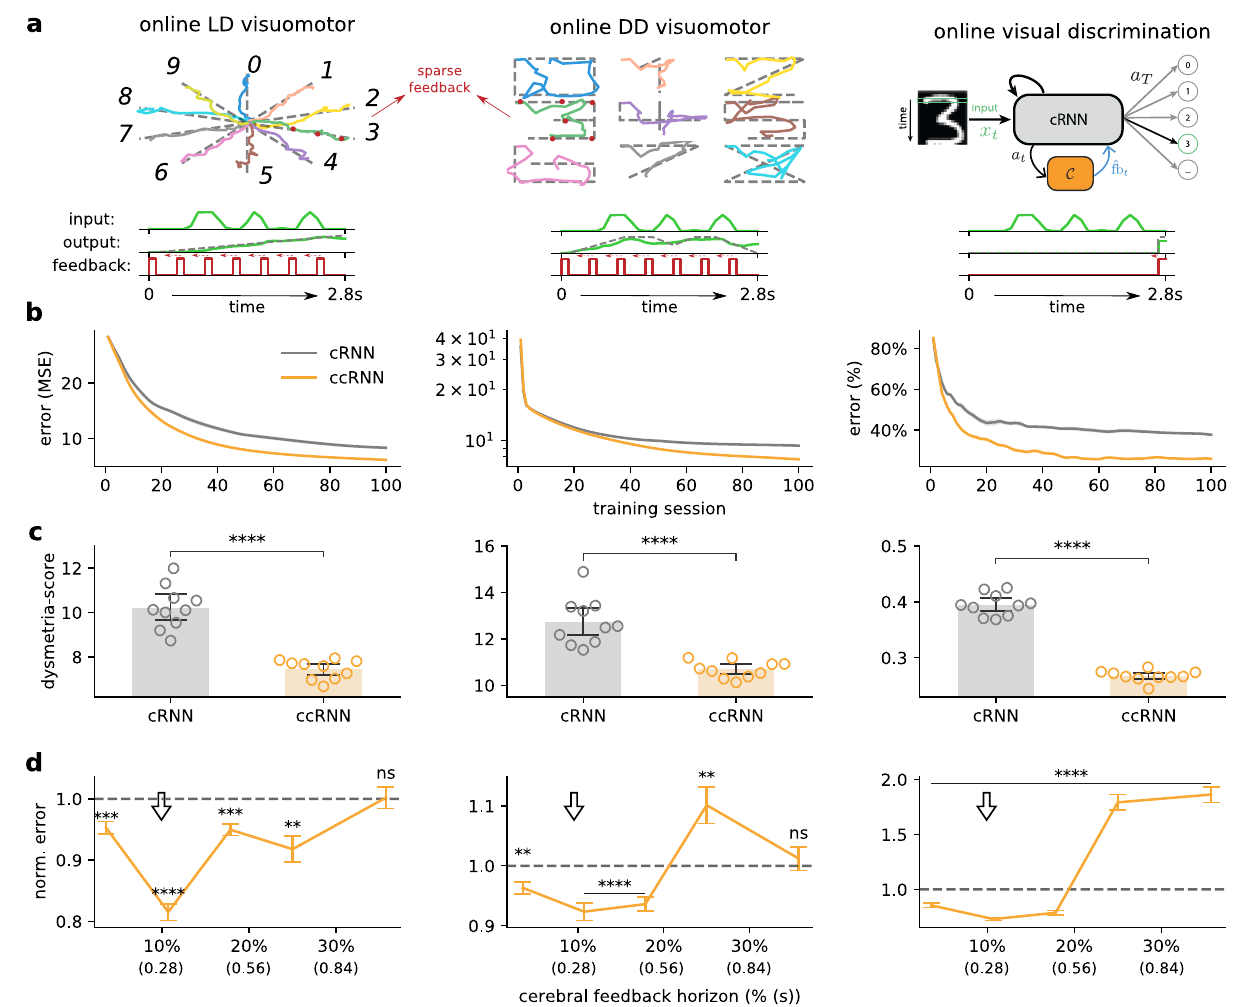
Fig. 3 | Cerebro-cerebellar model improves learning in online complex sen- sorimotor and sensory discrimination tasks. a Model behaviour across three tasks using a dataset of handwritten digits, each presented sequentially to the network(Methods and main text). Online line drawing (LD)visuomotortask: given temporallyvaryingvisualinputthemodelistrainedwithsparsefeedback(reddots) to draw a straight line (top left). Online digit drawing (DD) visuomotor task: given temporally varying visual input the model is trained to draw a digit following a template (top middle); target trajectories are in dotted grey and model input/ output is coloured by digit. Online visual discrimination task: pattern recognition variant in which the model is trained to discriminate between 10 different digits given as sequential input. A representation of the structure of the input (green), output(green;targetingrey)andfeedback(red)foreachtaskisalsogiven(bottom